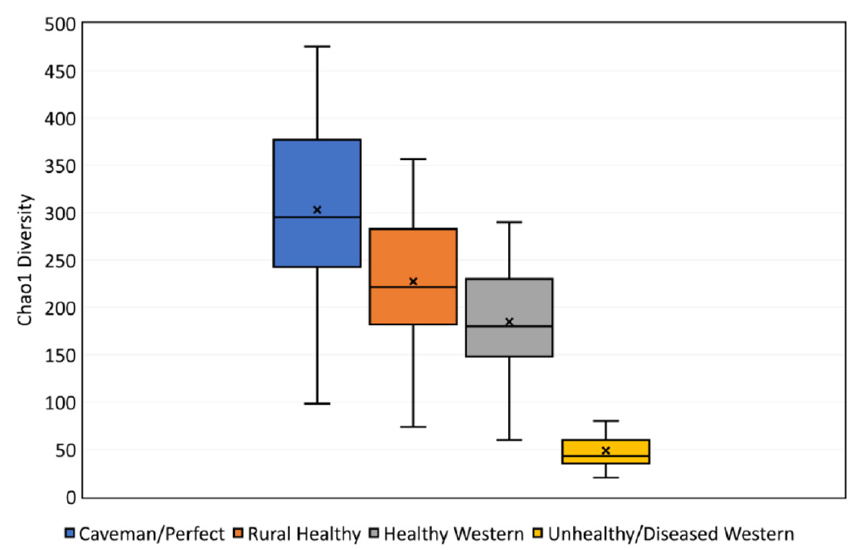
Figure 10. Boxplots showing the transferred Chao1 diversity benchmarks for “caveman/perfect skin” (blue), “rural healthy” (orange), and “unhealthy/diseased western” (yellow). The “healthy western skin” (grey) is taken directly from the data found in this study in Section 3.1, and the other benchmarks were created using the multiplication factors in Table 1. As all data in this study was rarefied to 6600 sequences, this is the read depth these benchmarks would apply at; at higher numbers of sequences, the diversity would change. This is a rough example of how we would transfer the benchmarks across, and future work will do this accurately, considering other factors.